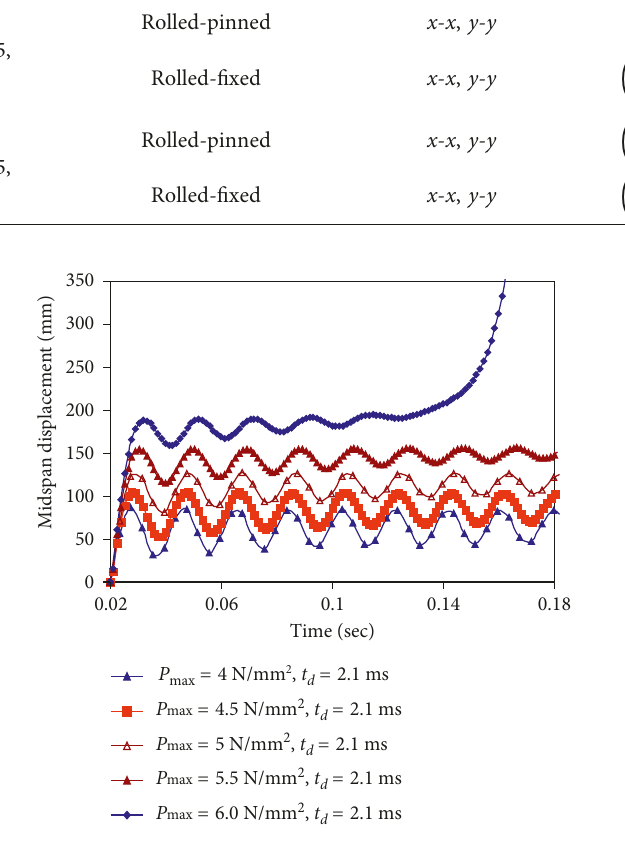
Figure 7: Midspan lateral displacement time histories of the steel column W150